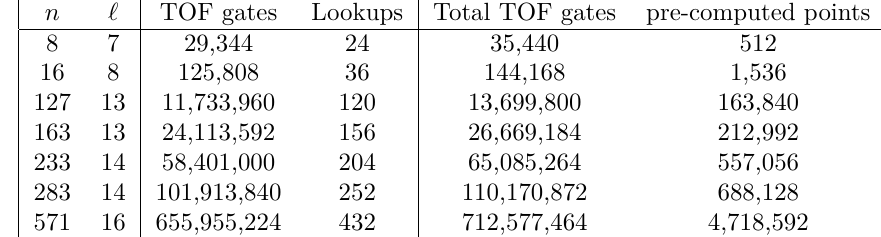
Table 6: TOF estimates for various Field sizes using 2(2 ‘ − 1) TOF gates per lookup. ‘ is optimized for this. Field polynomials from Table